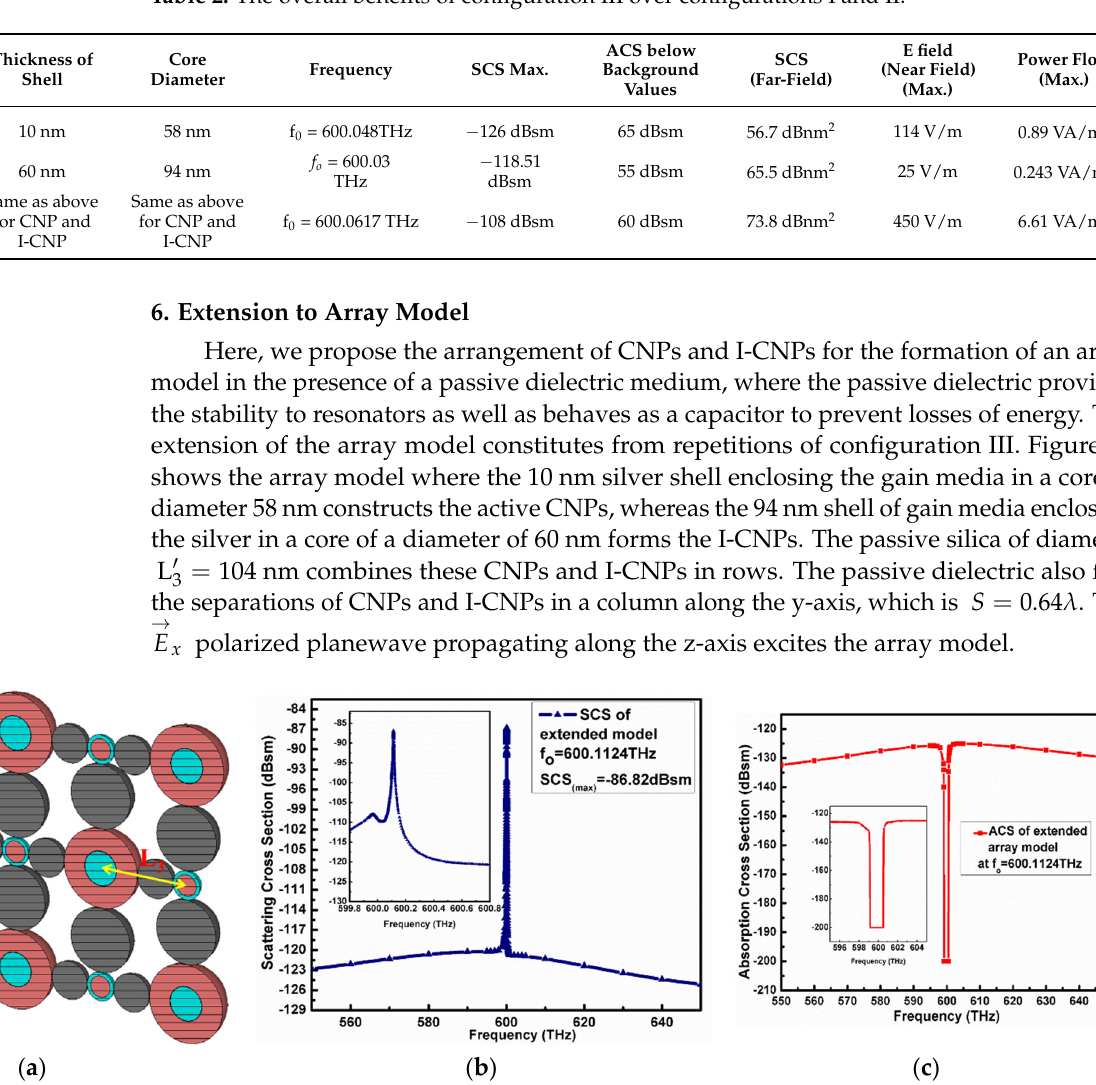
Table 2. The overall benefits of configuration III over configurations I and II.